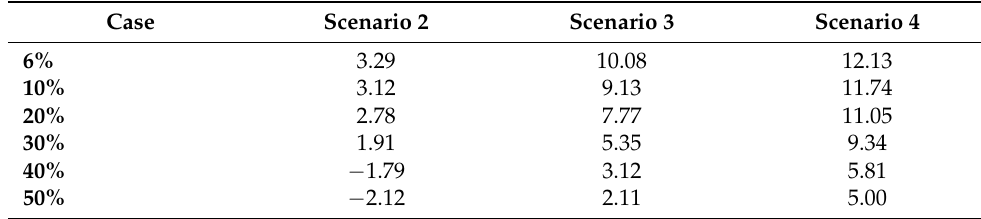
Table 5. Damping performance of local mode 2 with high RESs.